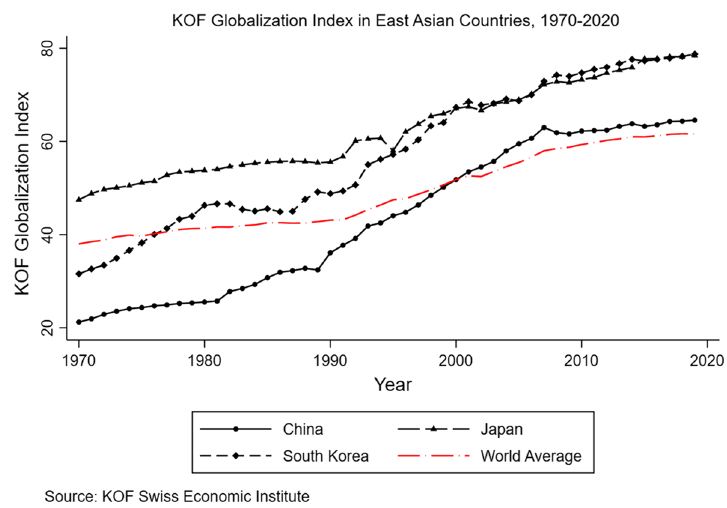
Fig. 1 KOF Globalization Index in China, Japan, and South Korea,